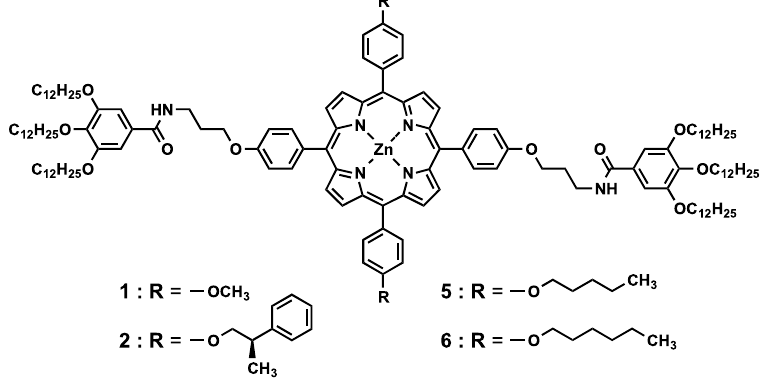
Figure 1. Molecular design. Structures of porphyrin derivatives ( 1 , 2 , 5 , and 6 ) used in this